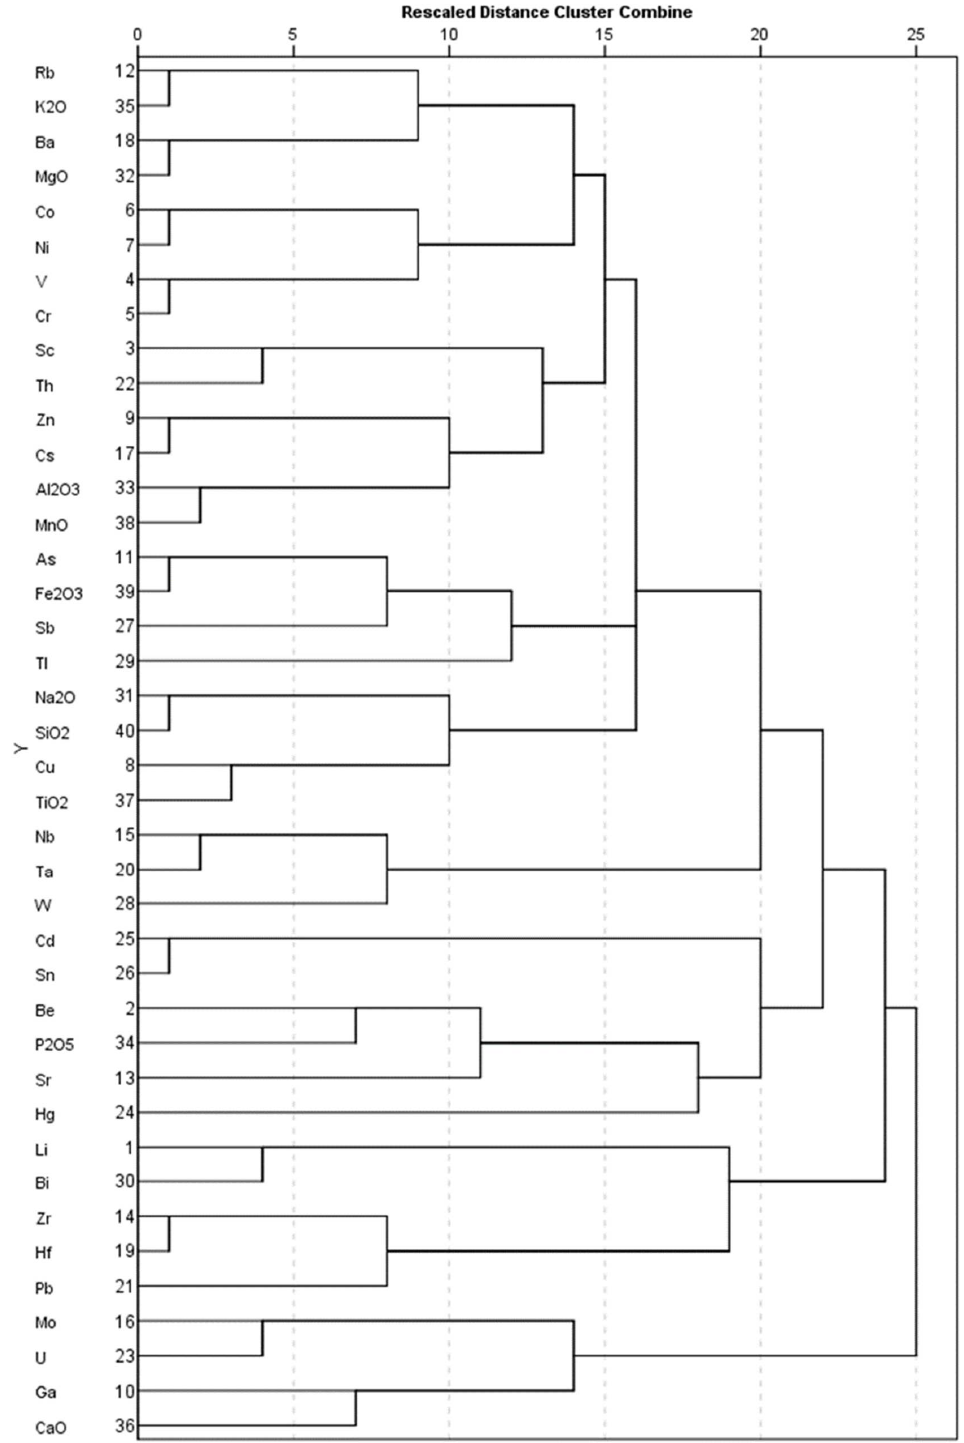
Figure 7. The cluster analysis of the geochemical data from the Pennsylvanian Pingshuo coal samples.